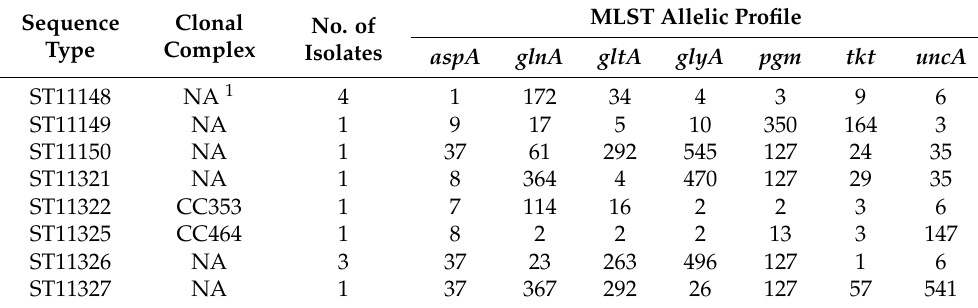
Table 2. Characteristics of the novel STs identified.